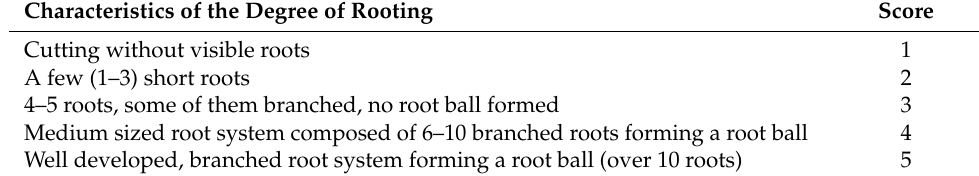
Table 2. Evaluation scale of the root